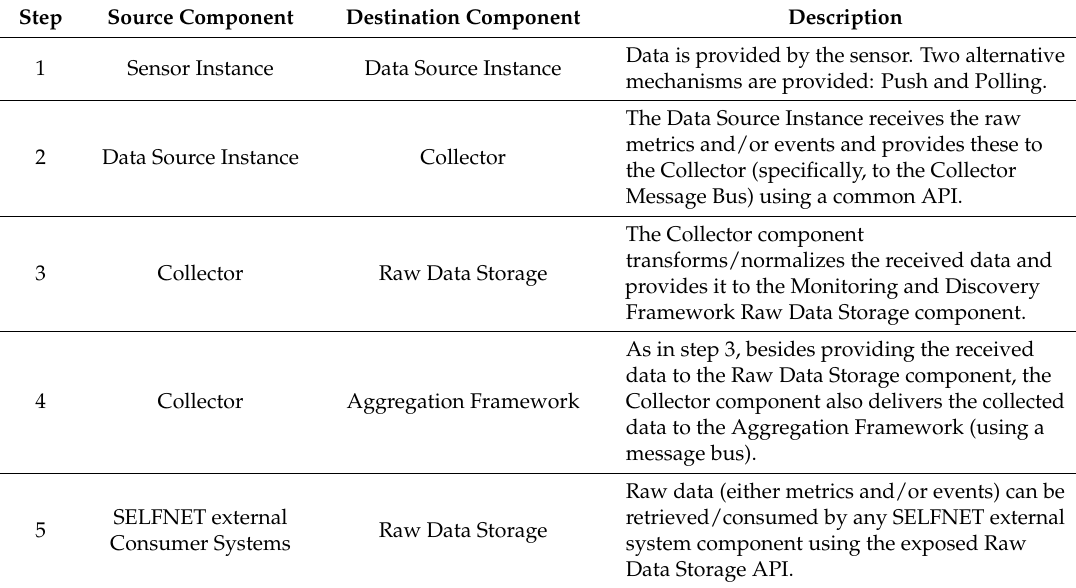
Table 7. Sensor Monitoring—Push Metrics and/or Events Workflow Steps.